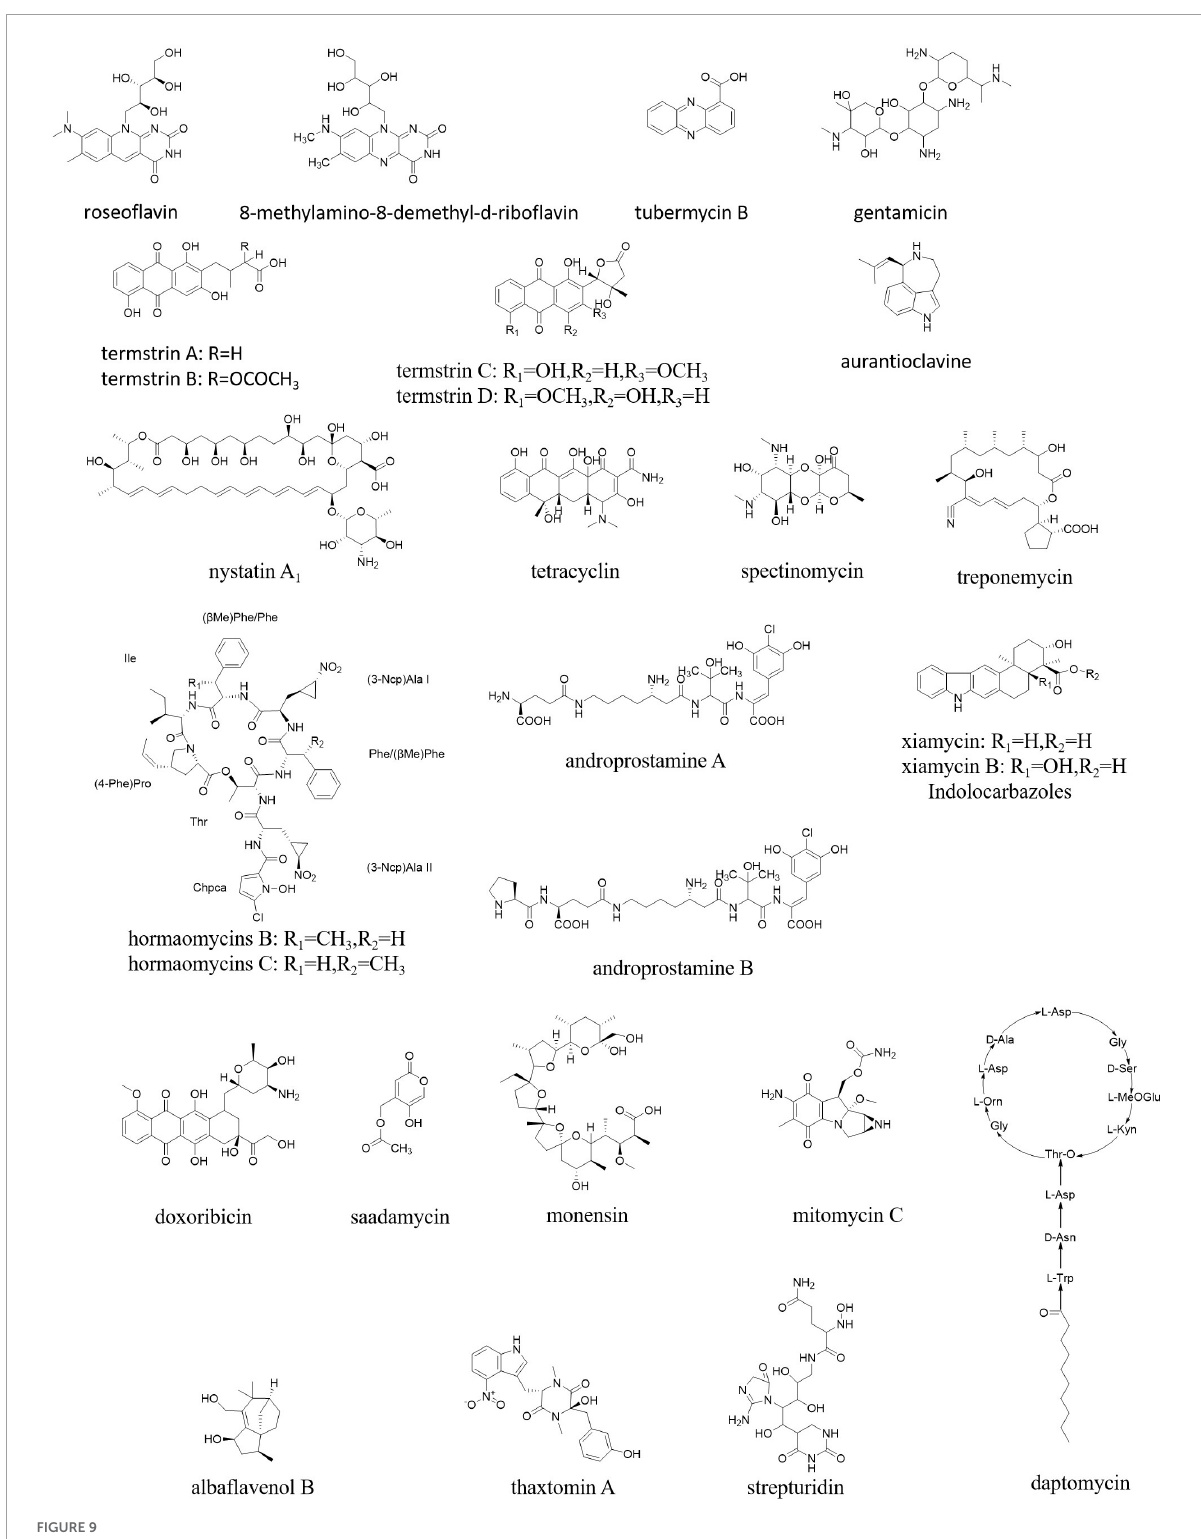
FIGURE9 Natural products from endophytic Streptomyces